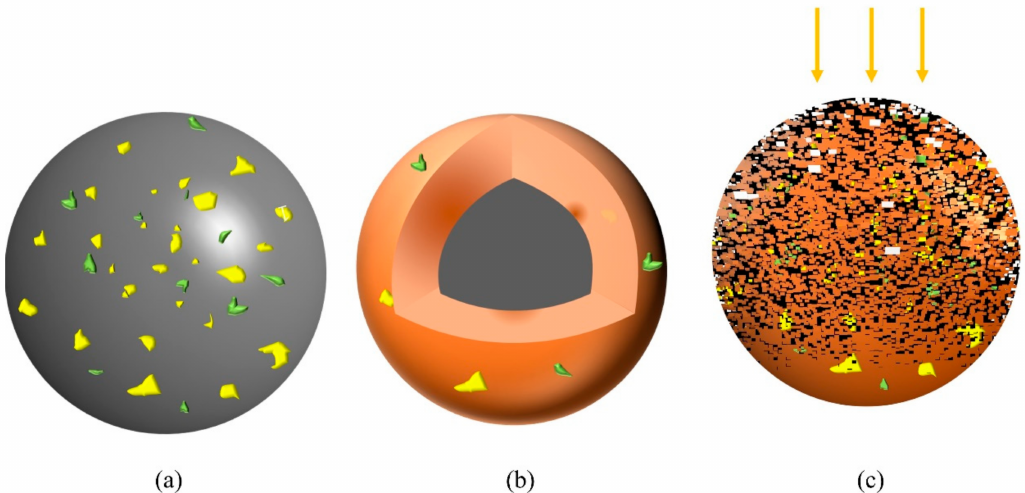
Figure 13. Schematic diagram of the SFCC catalyst under different condition (( a ) SFCC catalyst; ( b ) unreacted nucleation model, ( c ) fragmentation reaction